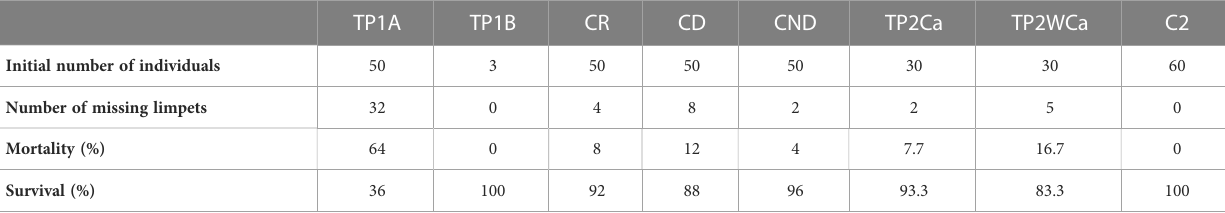
TABLE 2 Survival of P. ferruginea specimens relocated at the PJB in phase 1A (TP1A, Translocation phase 1A) and phase B (TP1B, Translocation phase 1B) from July 2021 to 31 October 2022, approximately 16 months, including controls (CR, receiver control; CD, donor control; CND, non-donor control), plus translocations in phase 2, with cage (TP2Ca) and without cage (TP2WCa) plus an added control for phase 2 (C2), from 15 May 2022 to October 2022, almost 6 months later.